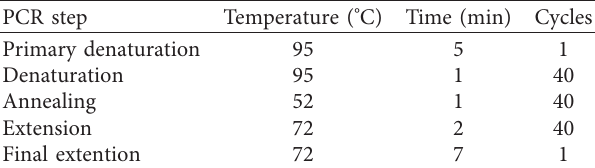
Table 2: PCR protocol for detection of aerobactin